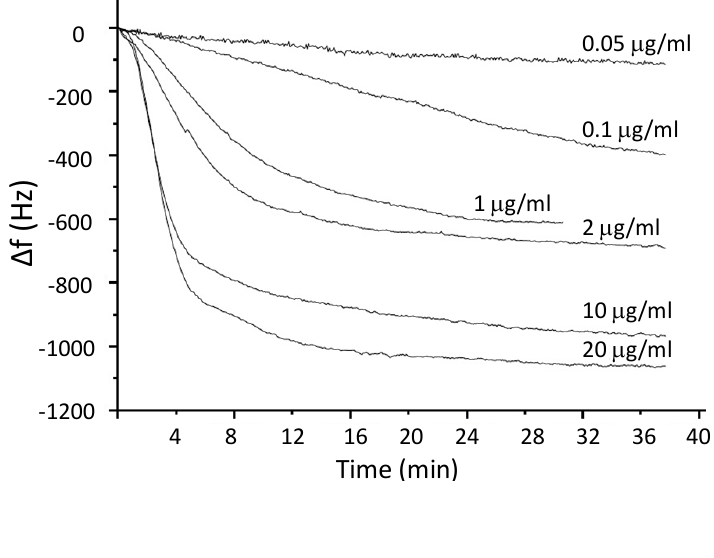
Figure 5. DNA-disulfide biosensor using the 50 MHz QCM oscillator circuit: frequency changes during the circulation of different concentrations of DNA target A HEPES